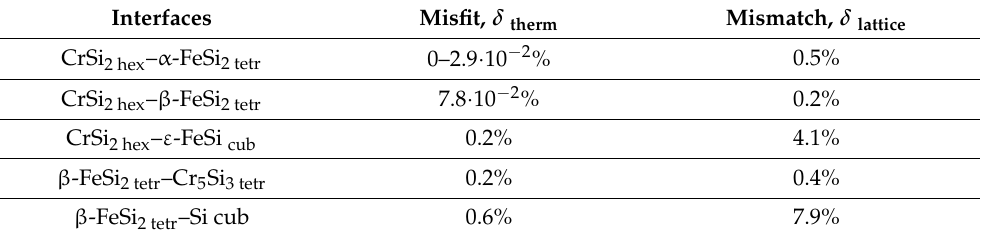
Table 4. The thermal expansion coefficient misfit and lattice mismatch at the interphase interfaces.